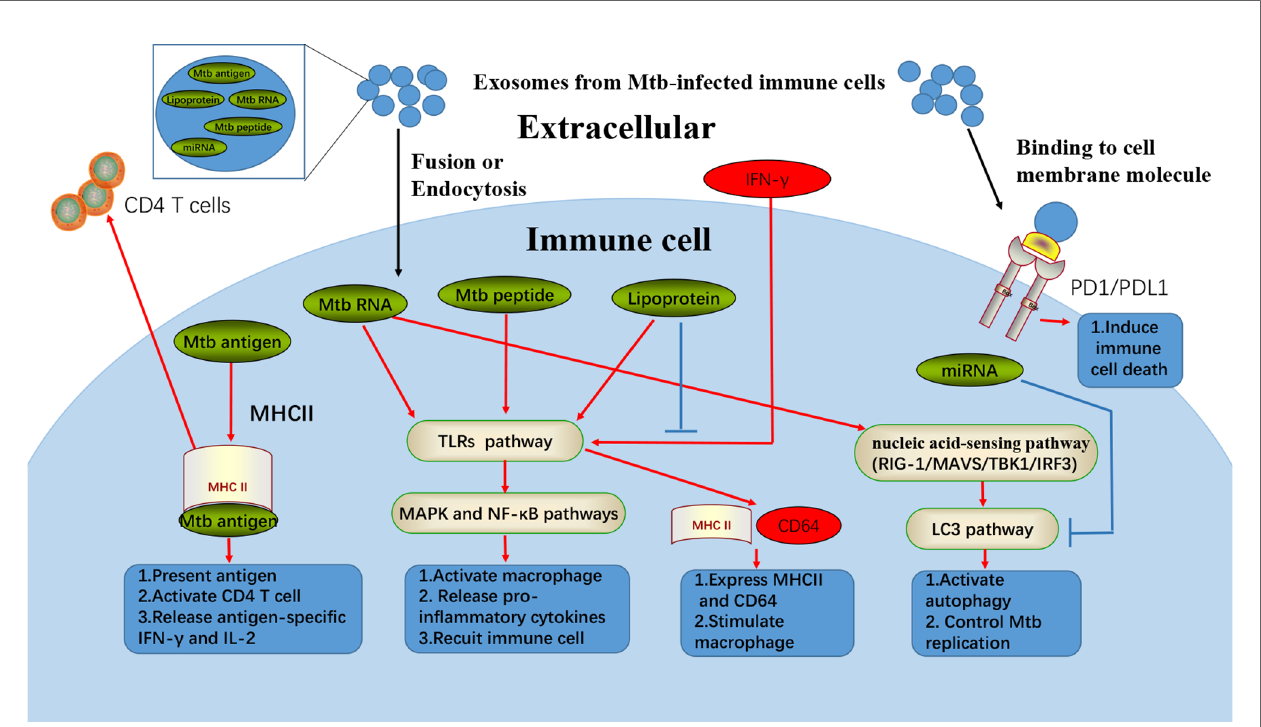
FIGURE 1 | Exosomes from Mtb-infected immune cells could induce multiple cellular responses. Exosomes from Mtb-infected immune cells contain various regulatory materials, such as Mtb antigens, Mtb RNA, Mtb peptide, lipoprotein, and miRNA. In fusion with cell membrane or passing through endocytosis, exosomes can release some Mtb speci fi c contents to induce different anti-Mtb responses in immune cells. Mtb antigens from exosomes can be transferred into uninfected-DC, where the antigens can combine with MHCII for antigen presentation and activating the adaptive immune systems. Mtb RNA, peptide, and lipoprotein from exosomes are found to be responsible for exosomes induced-in fl ammation, which are in strong association with TLRs, MAPK, and NF- k B pathways. Furthermore, Mtb RNA from exosomes can also stimulate macrophage autophagy through nucleic acid-sensing pathways (RIG-1/MAVS/TBK1/IRF3). However, exosomes from Mtb-infected immune cells can also inhibit anti-Mtb functions. For example, lipoprotein from exosomes can suppress the IFN- g induced MHCII and CD64 expression. Besides, miRNA from exosomes can inhibit autophagy of immune cells, while Mtb infection as well as PD1/PDL1 from exosomes can also act as immune